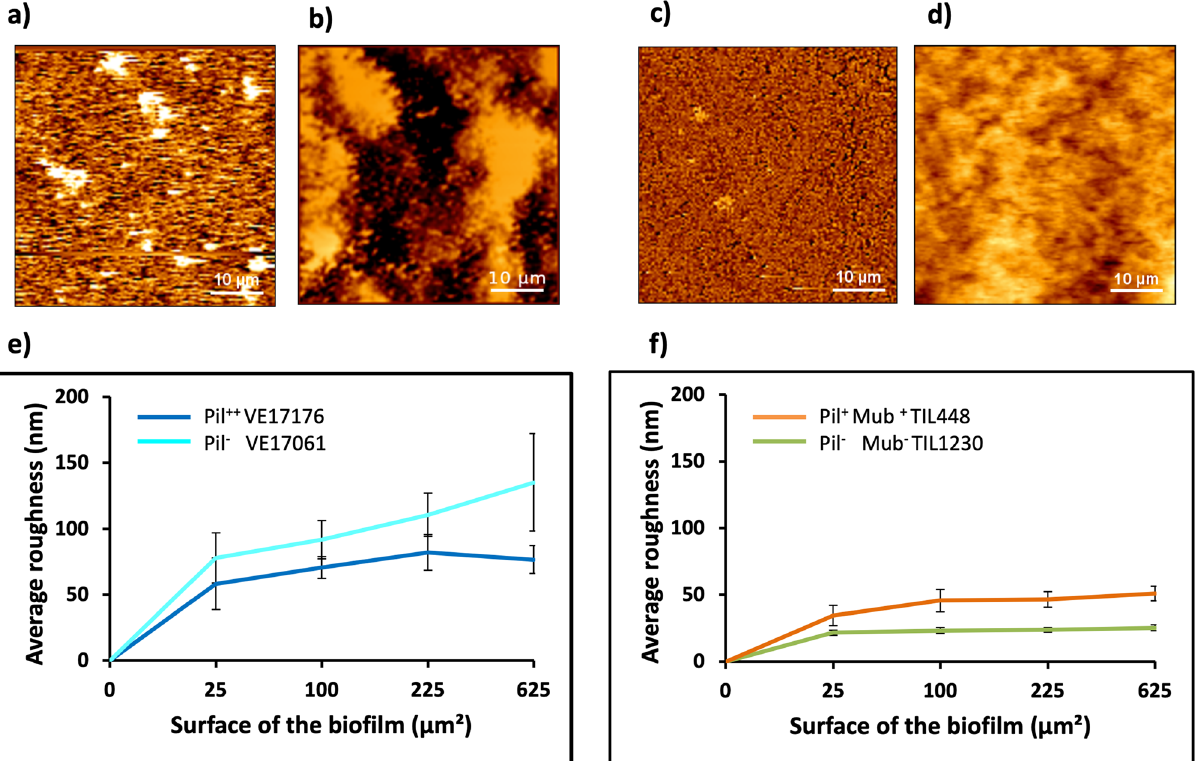
Figure 3. Roughness analyses of L. lactis biofilms using AFM technique. High resolution images of 24-h biofilms were recorded for Pil − VE17061 ( a ), Pil ++ VE17176 ( b ), Pil − Mub − TIL1230 ( c ) and Pil + Mub + TIL448 ( d ) strains. ( e ) and ( f ) showed the average roughness (Ra) measured on each biofilm for an area of 5 µm × 5 µm, 10 µm × 10 µm, 15 µm × 15 µm and 25 µm × 25 µm. The error bars in panel’s e and f denote three measurements from three independents